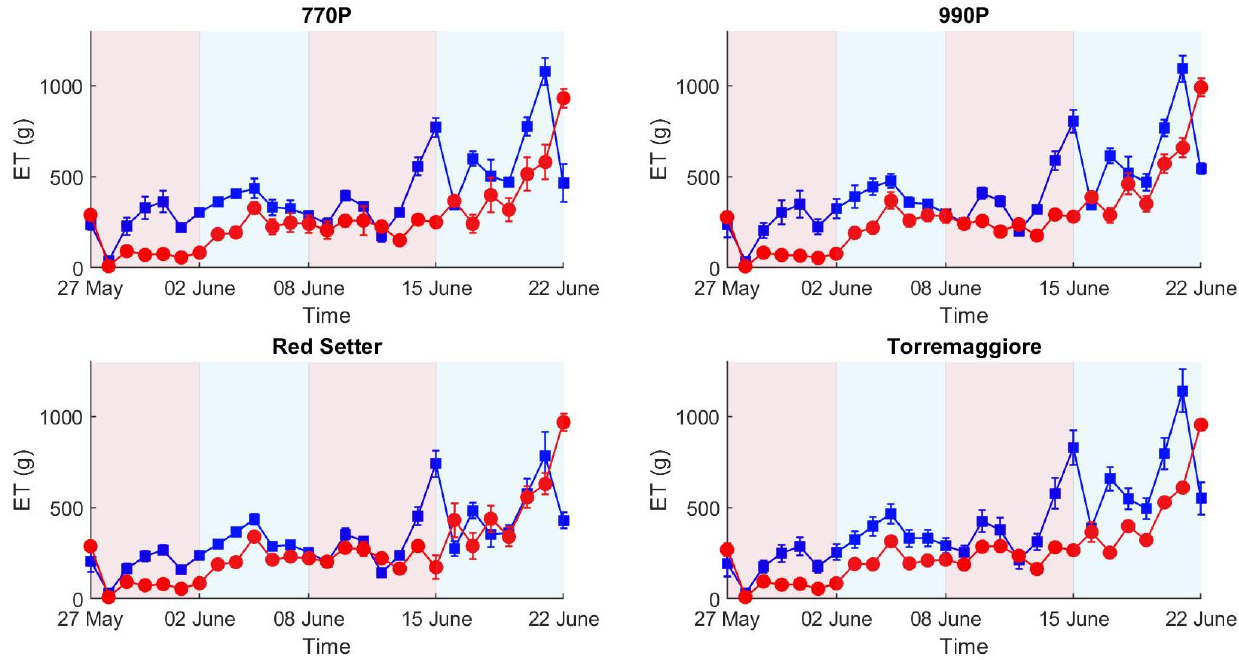
Figure 2. ET trend by 770P, 990P, Red Setter and Torremaggiore genotypes from the beginning to the end of the experiment. The red line represents the stressed thesis, and the blue line represents the control thesis. The red and blue areas in the plots represent the stress and full-irrigation experimental phases, respectively. Each point reports the mean of six samples and the associated standard deviation.